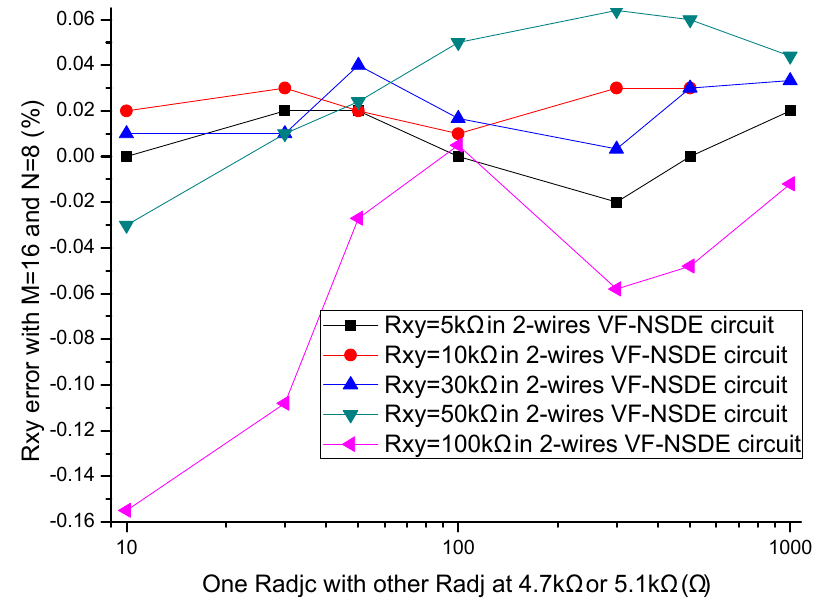
Figure 9. The R adjc effect on R xy errors in the two-wire VF-NSDE prototype circuit.